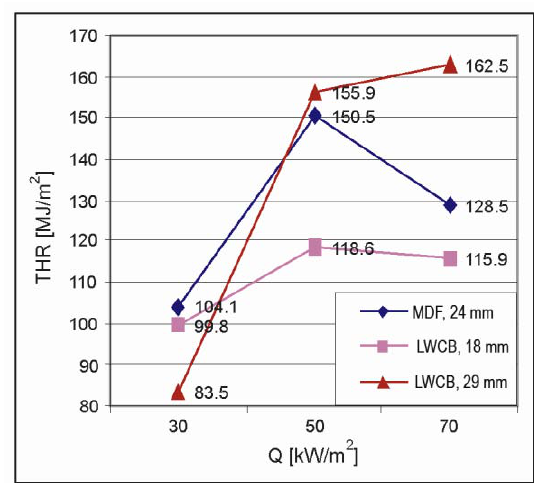
Fig. 11. Mean values of the efficient heat of combustion (EHC) when exposed to the surface heat flow of 30, 50 and 70 kW/m 2 density for different tested boards